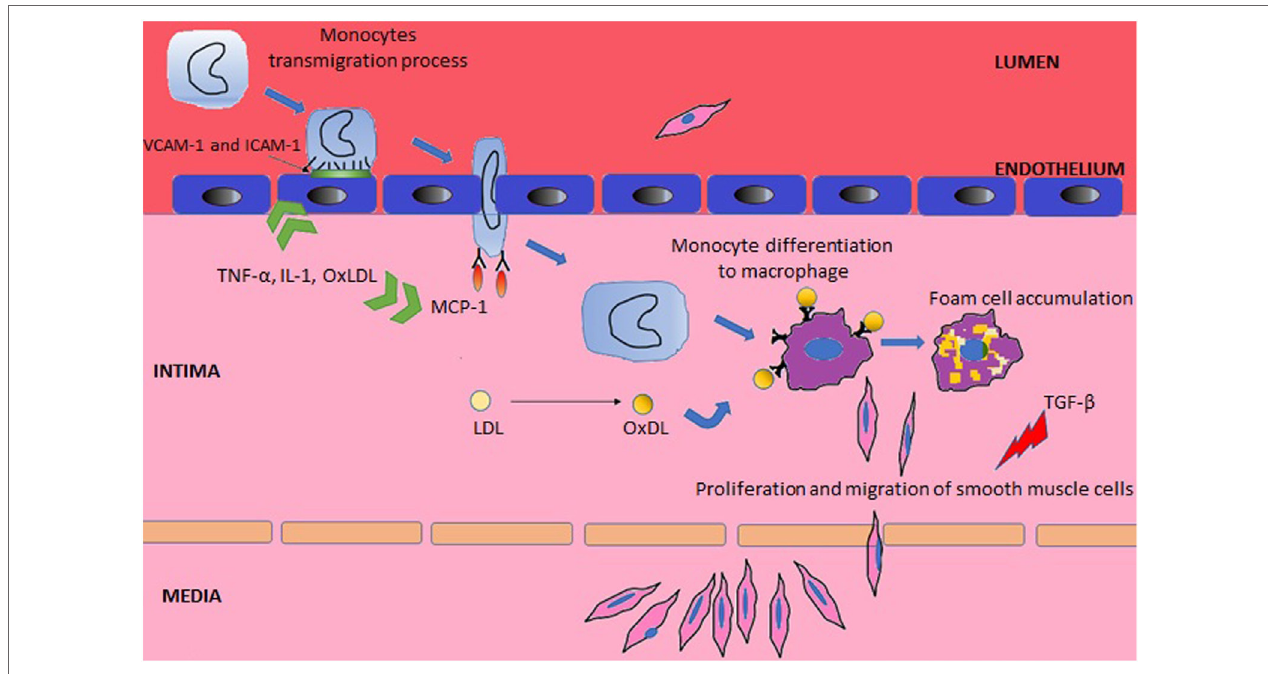
FiGURe 1 | Main steps in the pathogenesis of